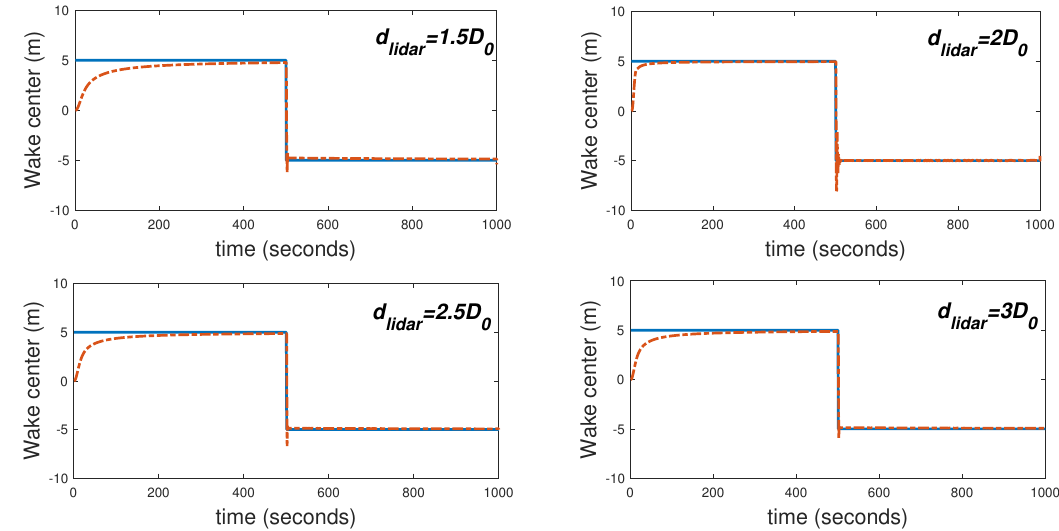
Figure 12. Wake center deflection based on multi-model approach. Blue (solid) line represents reference wake center and orange (dotted) represents estimated wake center